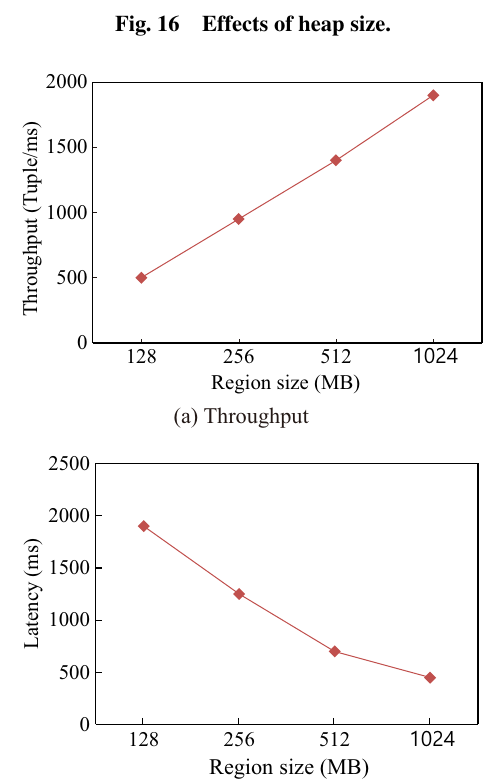
Fig. 16 Effects of heap size.